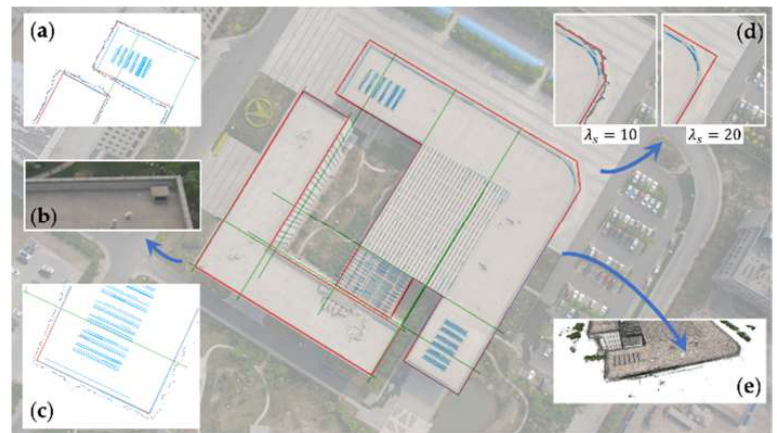
Figure 15. Optimized rooftop contours superimposed on the image. ( a ) The original boundary line is kept, not fitting to the image line which is the inner boundary. ( b ) The boundary of the façade is extruded upwards from the rooftop; thus, the intersection line is not the accurate upper outline of the adjacent façade. ( c ) The boundary line is snapped to the closest image line which represents the outer boundary. ( d ) The influence of the smooth-term coefficient. ( e ) The intersection information is lost in the absence of the adjacent façade.